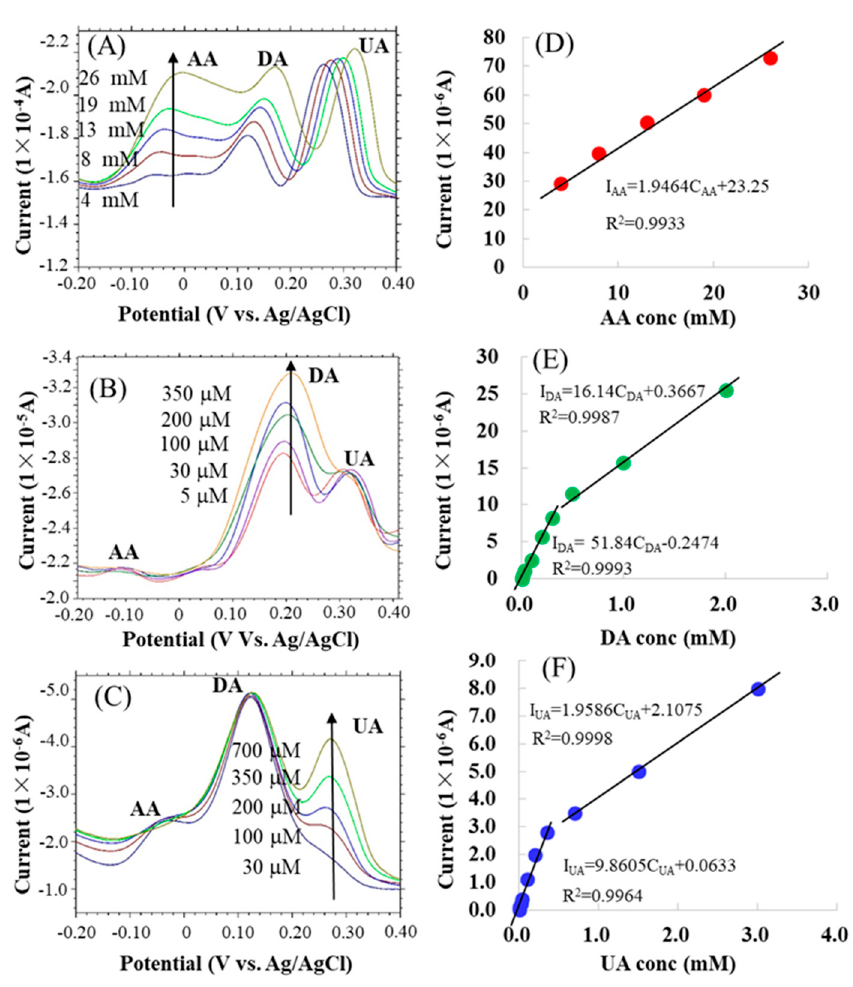
Figure 3. DPV curves of CB-CNT/PI/GCE in 0.1 M PBS (pH 7.0) with the AA/DA/UA mixtures: ( A ) 4 − 26 mM AA + 0.005 mM DA + 0.1 mM UA; ( B ) 5.0 mM AA + 5–350 µ M DA + 1 mM UA; ( C ) 1.0 mM AA + 0.1 mM DA + 30–700 µ M UA. ( D – F ) The oxidation current of substrates (I)